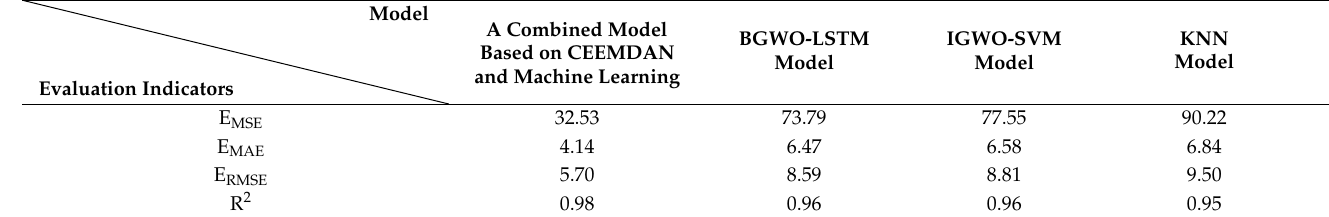
Table 3. Comprehensive comparison of four short-term traffic flow prediction